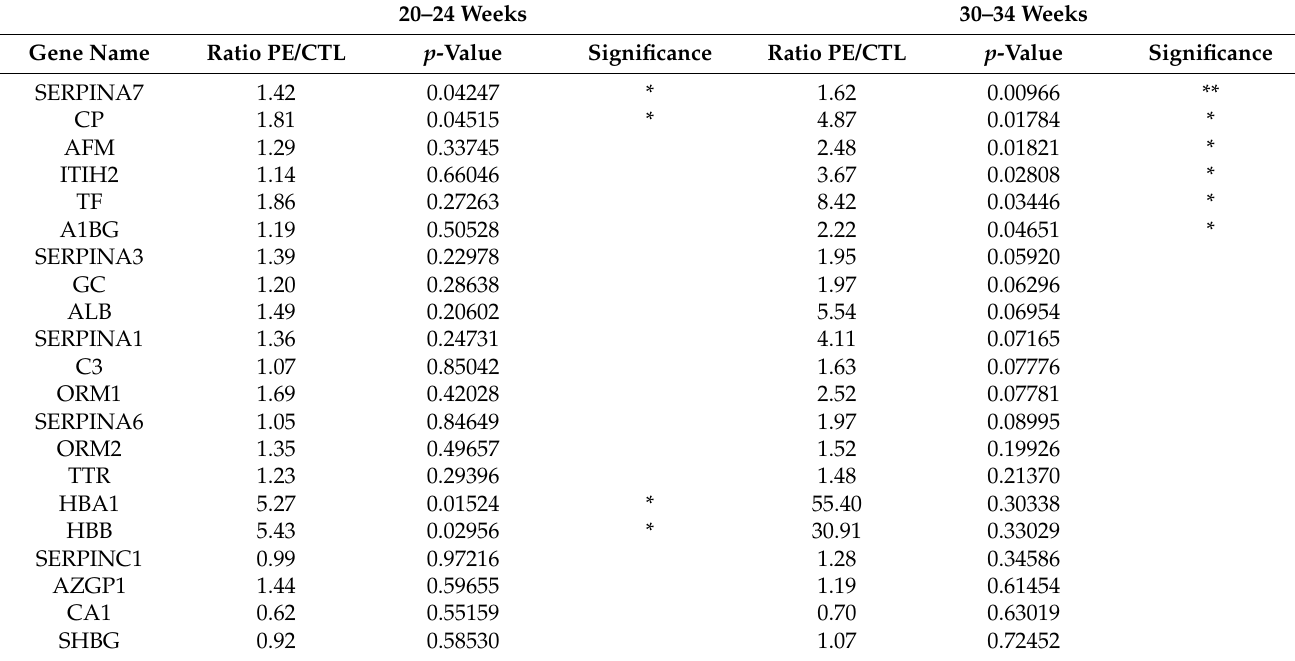
Table 3. Longitudinal study by targeted proteomics of 21 urinary proteins in women with and without